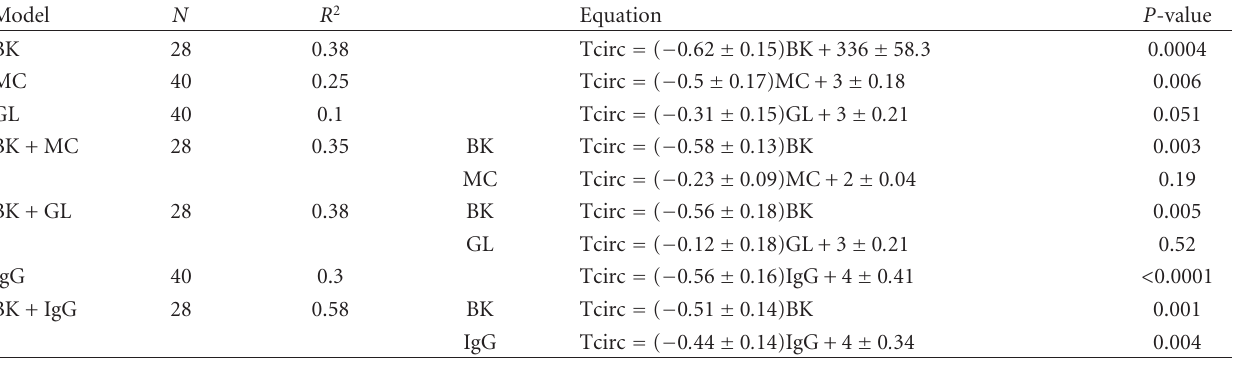
Table 2: Regression equations for the relationship between log in the abomasum (BK), numbers of mast cells (MC) and globule leukocytes (GL) in the abomasum, and concentrations of T. circumcincta - specific IgG 1 in plasma (IgG).